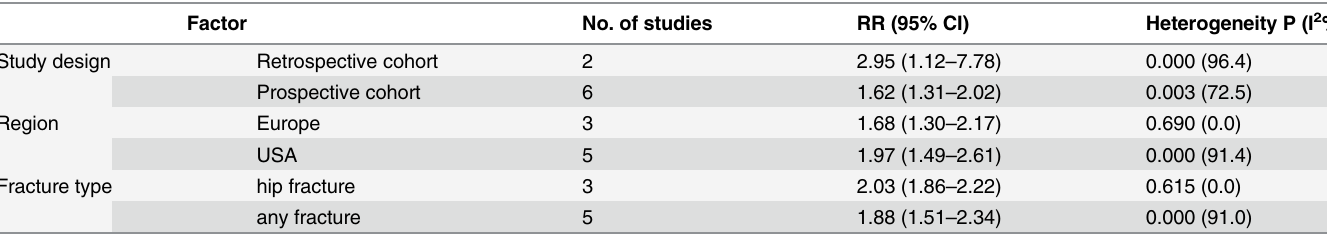
Table 2. Subgroup Analyses of the Association between Opioid Use and Fracture